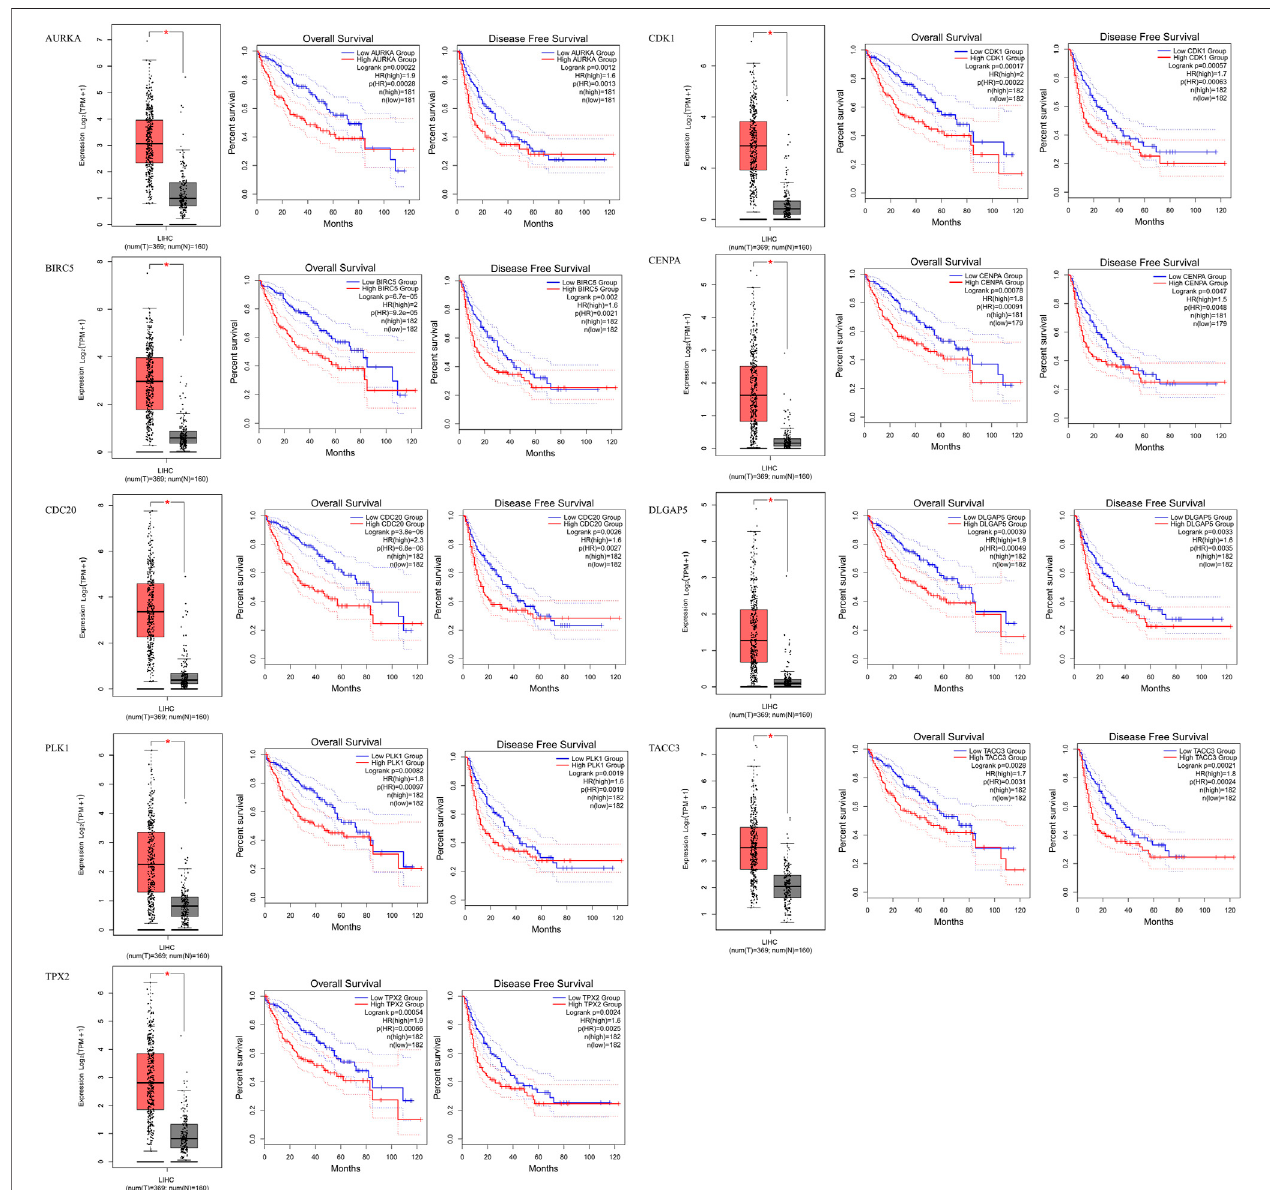
FIGURE 4 | Identi fi cation of prognostic genes. AURKA, BIRC5, CDC20, PLK1, TPX2, CDK1, CENPA, DLGAP5 and TACC3 gene expression levels were signi fi cantly higher in HCC patients, and these nine genes are related to overall survival and disease-free survival in HCC.